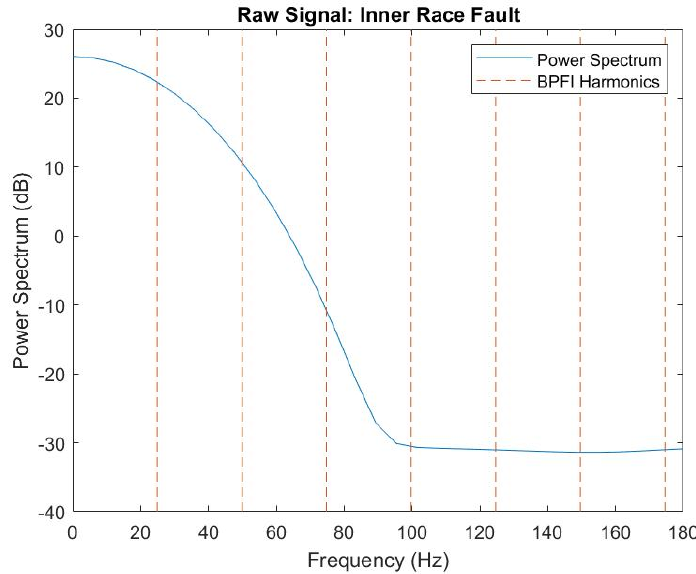
Figure 12. Power spectrum of raw signal.